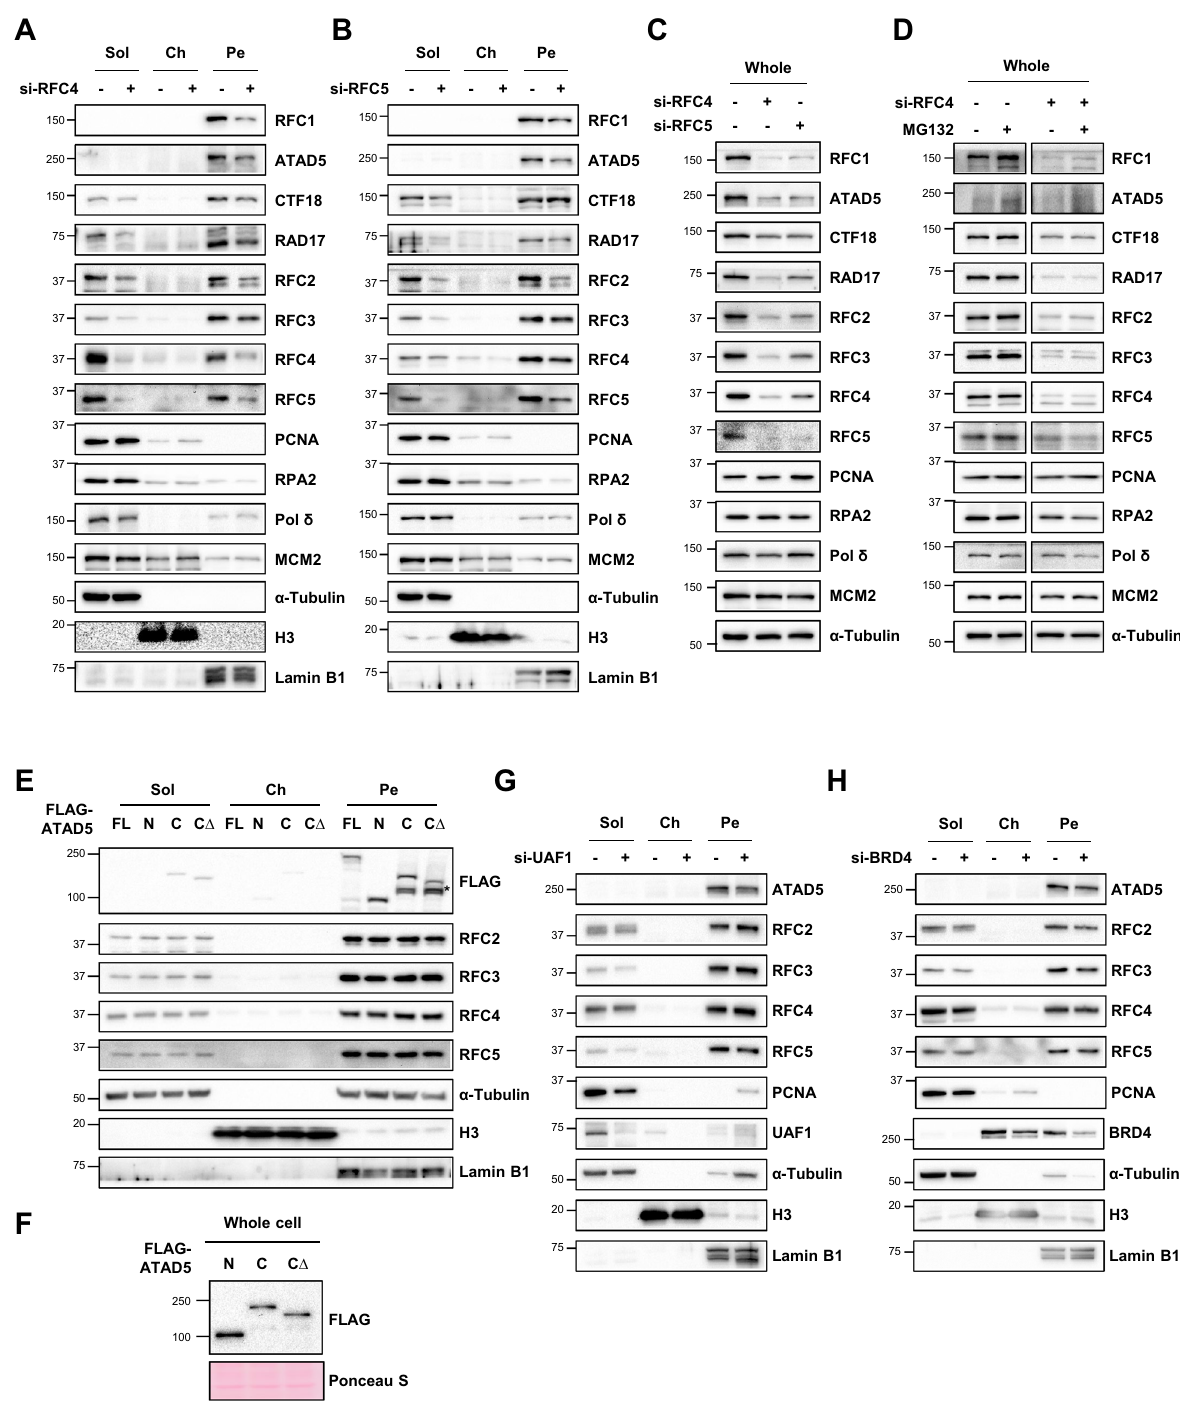
Figure 4. RFC4 and RFC5 maintain the protein levels of RFC/RLC proteins. ( A – D ) HeLa cells were transfected with siRNA as indicated. Forty-eight hours after transfection, cells were fractionated ( A , B ) or whole-cell extracts was prepared ( C , D ) for immunoblotting. ( D ) 10 μM MG132 was treated for 5 h before cell harvest. ( E , F ) HeLa cells were transfected with 3xFLAG-tagged full length ATAD5 (FL), N-terminal fragment (residues 1–693, N), C-terminal fragment (residues 694–1844, C) or small RFC interaction-defective C-terminal fragment (residues 694–1719, C∆) cDNA. Forty-eight hours after transfection, cells were fractionated ( E ) or whole-cell extracts were prepared ( F ), and then proteins were subjected to immunoblotting. ( E ) *, nonspecific band. ( G , H ) HeLa cells were transfected with siRNA as indicated and fractionated for immunoblotting. ( A – H ) Uncropped blot images are presented in Supplementary Fig.